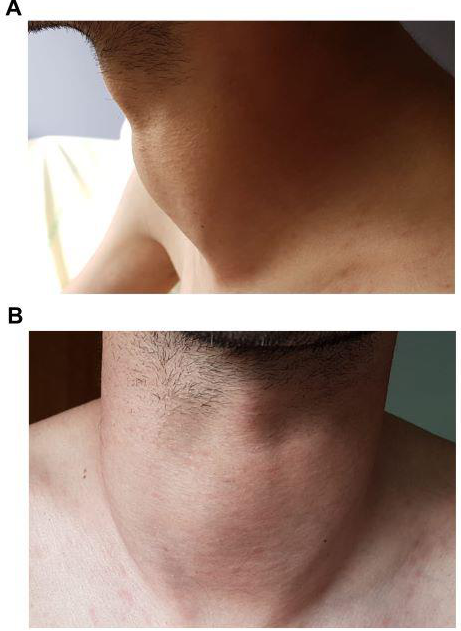
Figure 4. Clinical goiter.